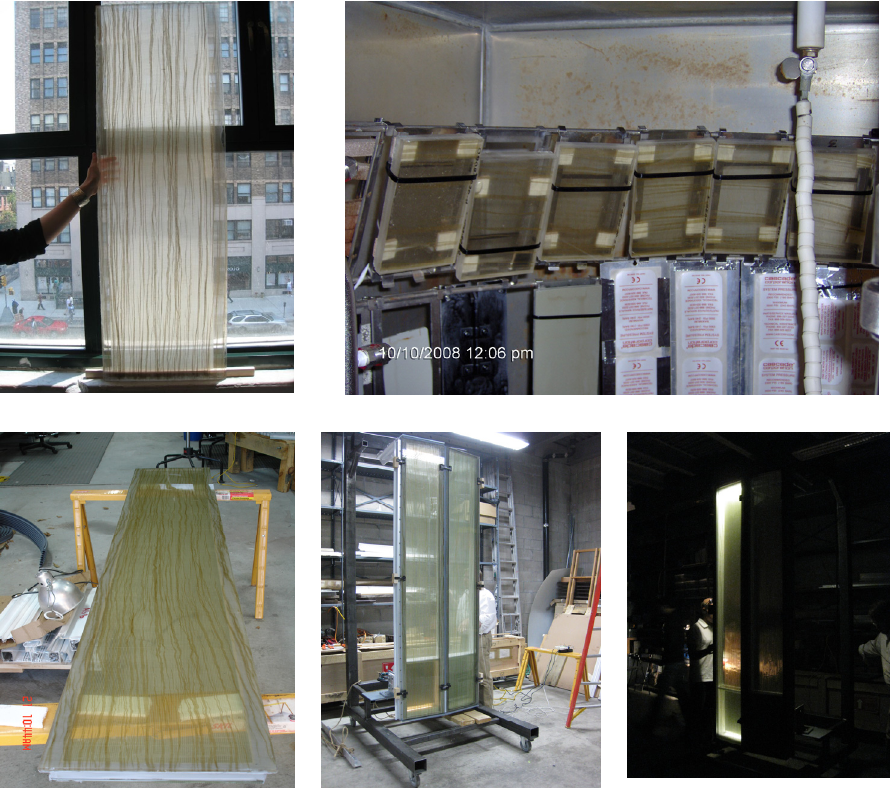
Figure 6a, b, c, d: Visual Mock-Up, Test Samples, Production Panel, Assembly Mock-Up with